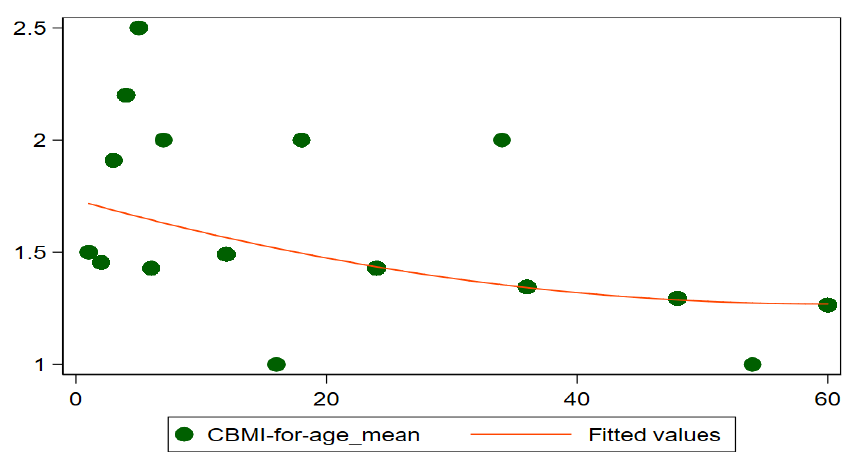
Figure 4. Mean Z − Scores (CBMI) by age in months.